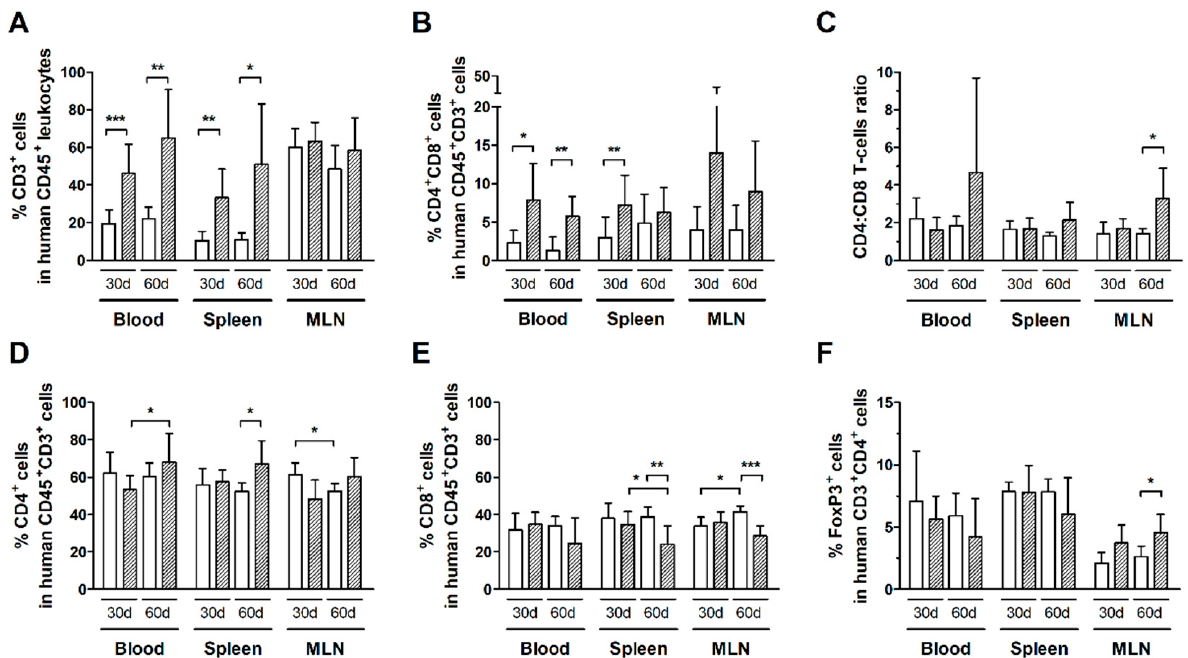
Figure 2. Frequency of T-cell subsets in HTLV-1-infected and normal HIS-NSG mice. Blood, spleen, and mesenteric lymph nodes (MLN) from control (white box) and HTLV-1-infected HIS-NSG mice (dashed box) were collected at 30 days and 60 days from inoculation. Human T-cell subsets were determined by flow cytometry according to the gating strategy shown in the additional file: Figure S1. ( A ) The frequency of T-cells (CD3 + cells) is shown in human leukocytes (CD45 + cells), and that of ( B ) CD4 + CD8 + double-positive cells is shown in human T-cells (CD45 + CD3 + cells). ( C ) The CD4:CD8 ratio represents the proportion between CD4 + and CD8 + single-positive T-cells, and ( D ) the frequencies of CD4 + and ( E ) CD8 + single-positive cells are shown in human CD45 + CD3 + cells. ( F ) The frequency of FoxP3 + cells is shown in CD4 + T-cells. Results are shown as mean percentage with standard deviation bars. Statistical analysis was performed with Student’s t -test by pairwise comparisons, and adjusted p -values were selected when equal variances were not assumed by Levene’s test (*, p < 0.05; **, p < 0.01; ***, p < 0.001). Control groups 30 d and 60 d: n = 7; HTLV-1-infected group 30 d: n = 8; HTLV-1-infected group 60 d: n = 6.